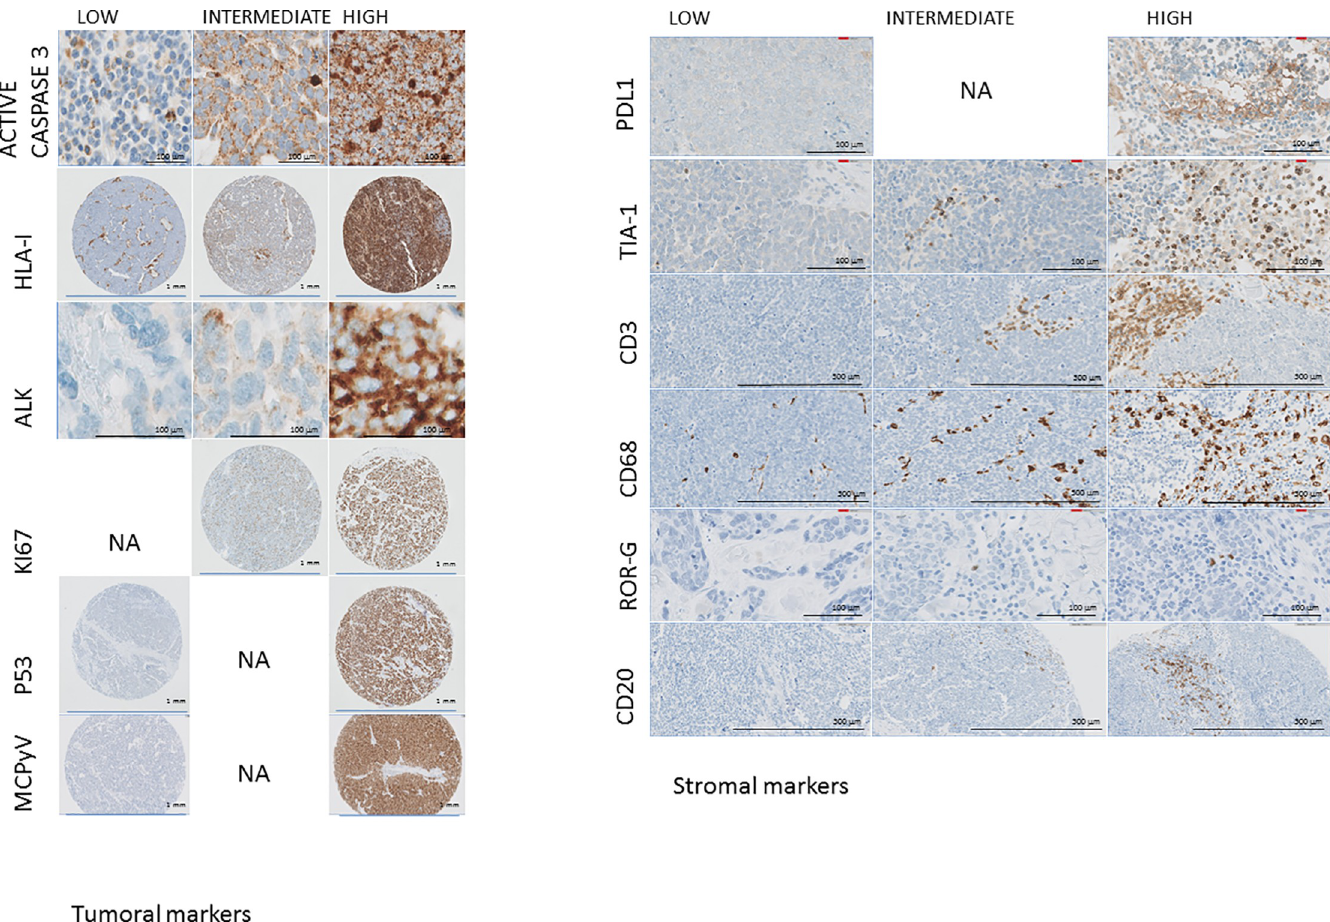
Fig 2. Differences in the expression of the most significant markers. A: Neoplastic cells: Caspase 3, HLA-I, ALK, KI67, P53. B: Tumor stroma: PDL1, TIA1, CD3, CD68, ROR GAMMA, CD20.